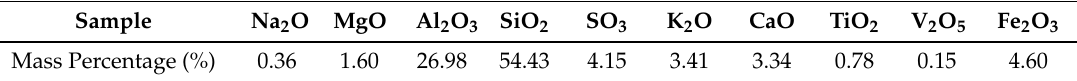
Table 2. Concentrations of major element oxides in the coal ash sample.